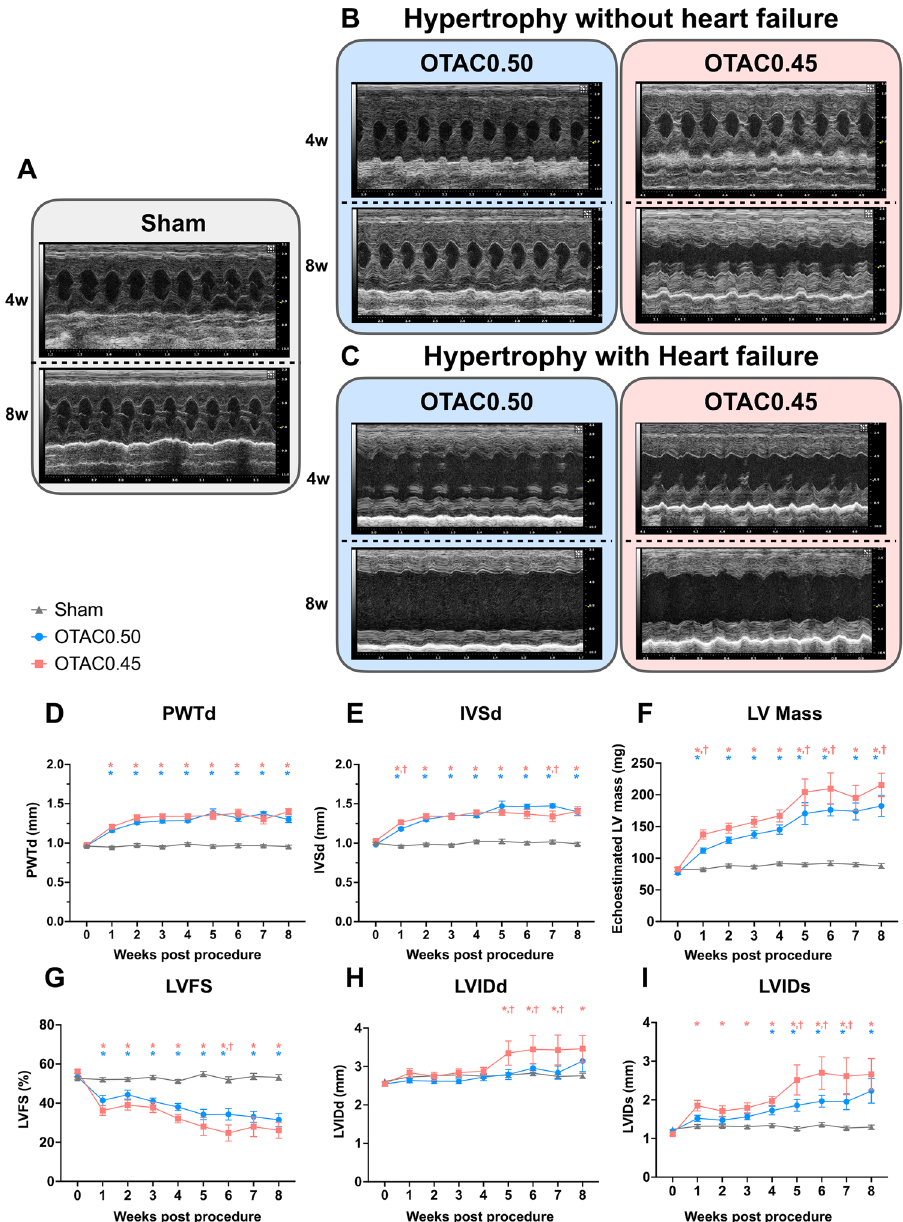
Figure 4. Echocardiographic analyses before and after OTAC and Sham. ( A–C ) Representative echocardiographic M-mode of mice 4 weeks and 8 weeks after the procedure; Sham ( A ), hypertrophy by OTAC ( B ), and heart failure with hypertrophy by OTAC ( C ). The x-axis represents the time (in ms), and the y-axis represents the distance (in mm) from the transducer. ( D–I ) Echocardiographic measurements of left ventricular posterior wall thickness in diastole: PWTd ( D ), interventricular septum in diastole: IVSd ( E) , LV mass ( F ), LV fractional shortening: FS ( G ), LV internal dimension in end-diastolic dimension: LVIDd ( H) and end-systolic dimension: LVIDs ( I ) were measured at 8 weeks post-procedure. Repeated measurement among groups was performed by two-way ANOVA with Tukey’s post hoc test; n = 9–14. * P < 0.05 versus Sham; † P < 0.05 versus